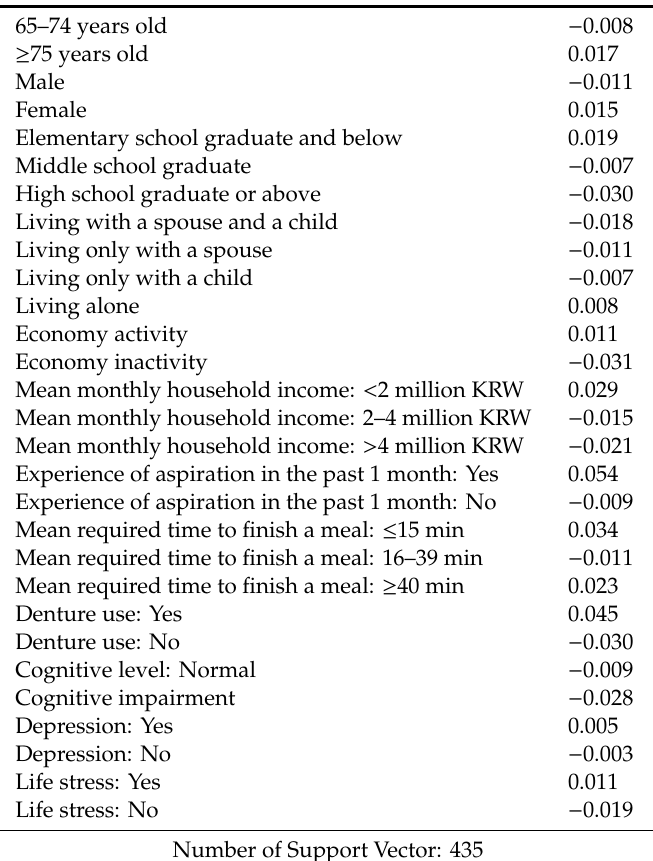
Table 3. The function weights of Gaussian kernel algorithm.